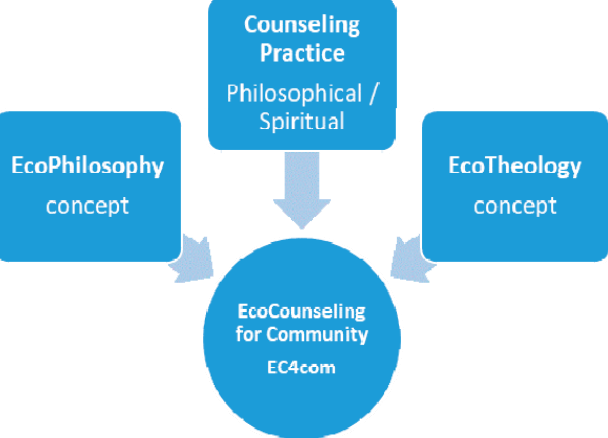
Figure 6. Initiation of the community counseling practice program.